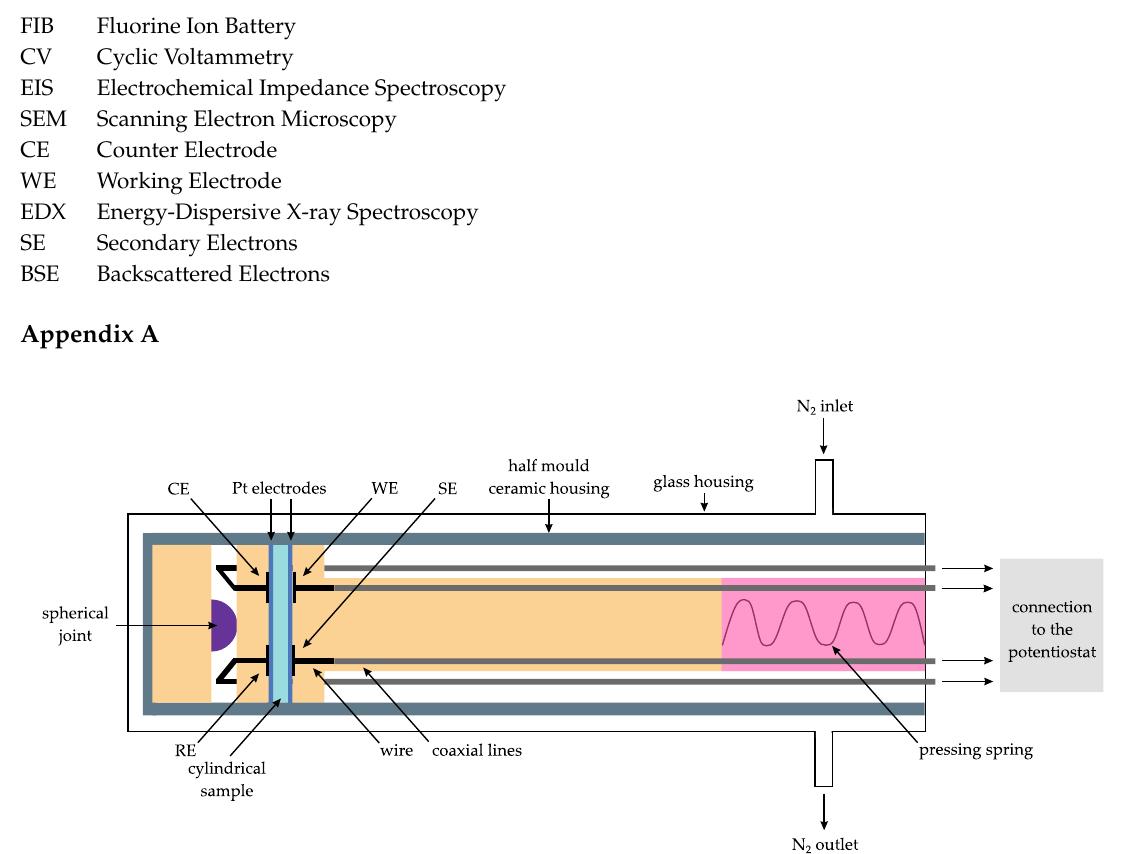
Figure A1. Scematic drawing of the cell set-up for conducting solid state Cyclic Voltammetry in a two-electrode